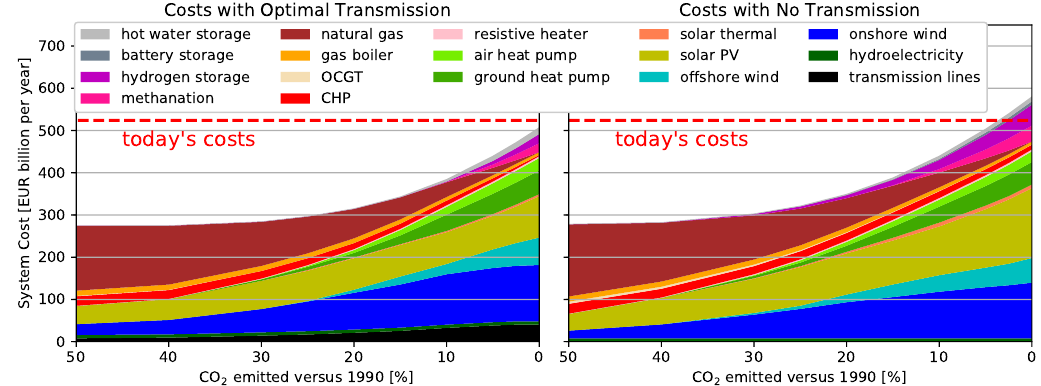
Figure 3. System costs for electricity, land transport, and space and water heating in Europe with a changing CO 2 limit, assuming the 2030 cost projections from Table 1. Left is the case with cost-optimal transmission, right is with no transmission. Estimated costs for today’s system are marked with a red dashed